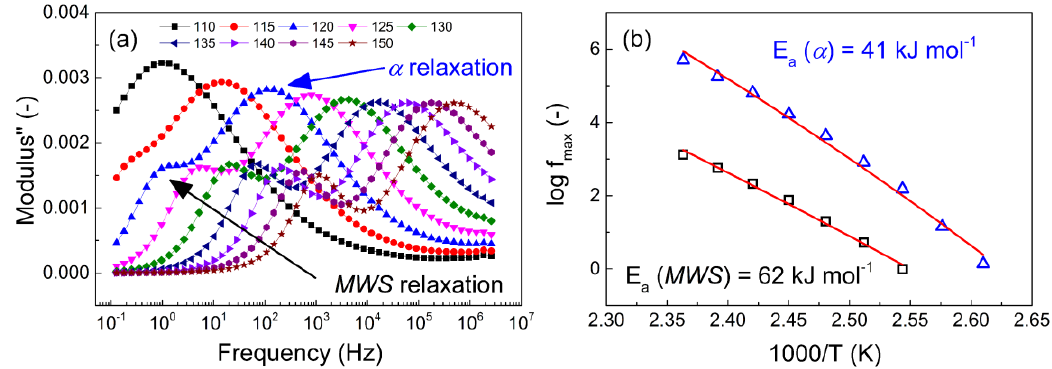
Figure 9. ( a ) The dielectric spectra of the neat coPA composite thin film at various temperatures and ( b ) the Vogel – Fulcher – Tammann plot of the two types of relaxations. These relaxations are clearly visible only after recalculation of the dielectric loss factor to the loss